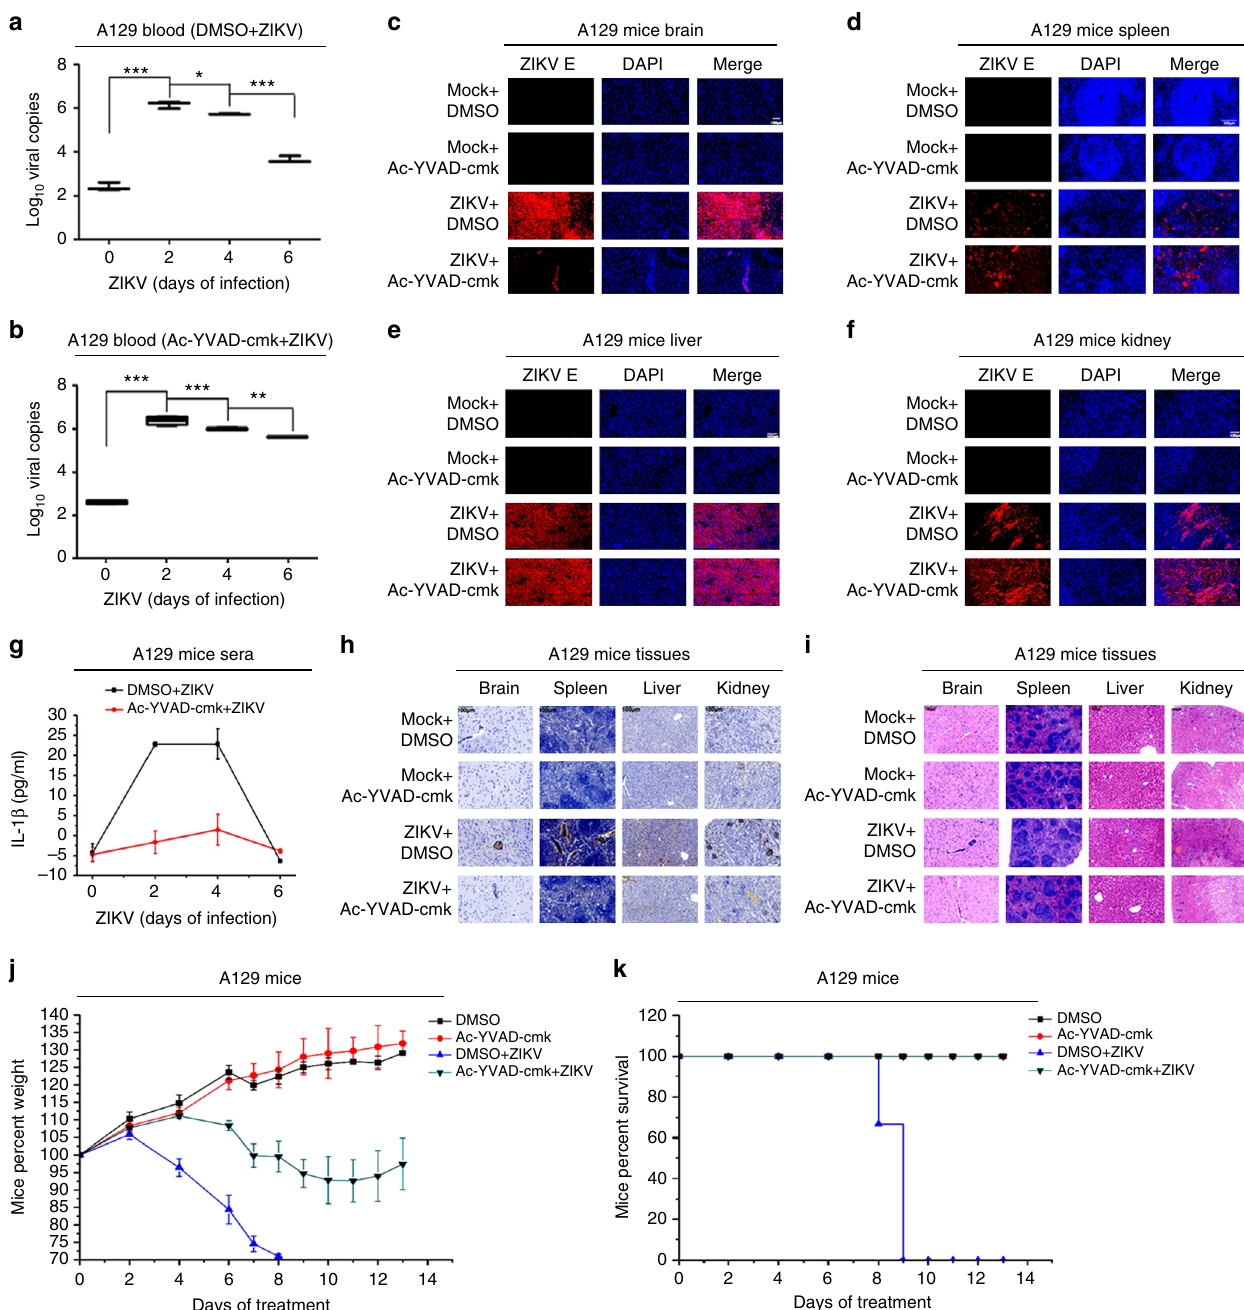
Fig. 8 The effect of caspase-1 inhibitor on ZIKV-induced in fl ammatory responses in mice. A129 mice (6 weeks old) were treated with DMSO or Ac-YVAD- cmk (8 mg/kg) by intraperitoneal injection 30 min and infected with ZIKV (5 × 10 5 PFU) or treated with PBS for the indicated times. a , b A129 mice were pretreated with DMSO ( n = 3; 2 males and 1 female) ( a ) or Ac-YVAD-cmk ( n = 3; 2 males and 1 female) ( b ) and then infected with ZIKV (5 × 10 5 PFU) for 0, 2, 4, and 6 days. ZIKV RNA in the mice blood was determined by RT-PCR. Data shown are whiskers: Min. – max.; * P < 0.05, ** P < 0.01, *** P < 0.0001 (one-way ANOVA with Tukey ’ s post-hoc test). c – f A129 mice pretreated with DMSO ( n = 3; 2 males and 1 female) or Ac-YVAD-cmk ( n = 3; 2 males and 1 female) were infected with ZIKV (5 × 10 5 PFU) for 11 days. The mice brain, spleen, liver, and kidney tissue sections were stained with DAPI to label nuclei (blue) and an antibody against ZIKV E protein (red) and then examined under confocal microscopy. Scale bar is 100 μ m. g A129 mice pretreated with DMSO ( n = 3; 2 males and 1 female) or Ac-YVAD-cmk ( n = 4; 2 males and 2 females) were infected with ZIKV (5 × 10 5 PFU) for 0, 2, 4, and 6 days. IL-1 β levels in mice sera were determined by ELISA. Data shown are means ± s.e.m. h – k A129 mice pretreated with DMSO ( n = 3; 2 males and 1 female) or Ac-YVAD-cmk ( n = 4; 2 males and 2 females) were infected with ZIKV (5 × 10 5 PFU). At 11 days posttreatment, the mice brain, spleen, liver, and kidney tissue samples were stained with IL-1 β antibody ( h ) or stained with hematoxylin and eosin (H&E) ( i ) and then examined using a light microscope. At 0, 2, 4, 6, 7, 8, 9, 10, 11, 12, and 13 days posttreatment, the mice body weights ( j ) and survival rates ( k ) were evaluated. Scale bar is 100 μ m ( h , i ). Data shown are means ± s.e.m ( j